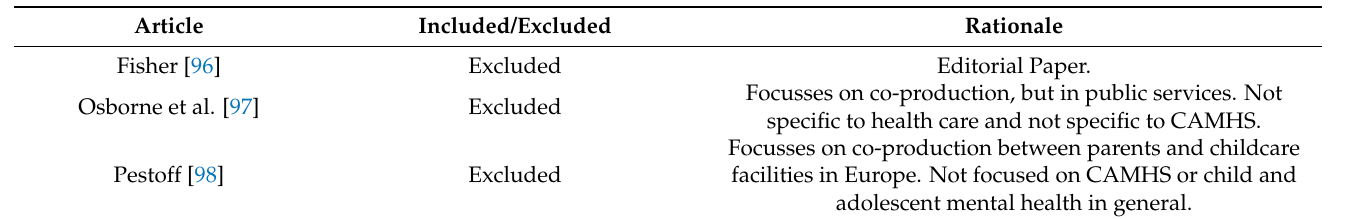
Table A3. Reference search.